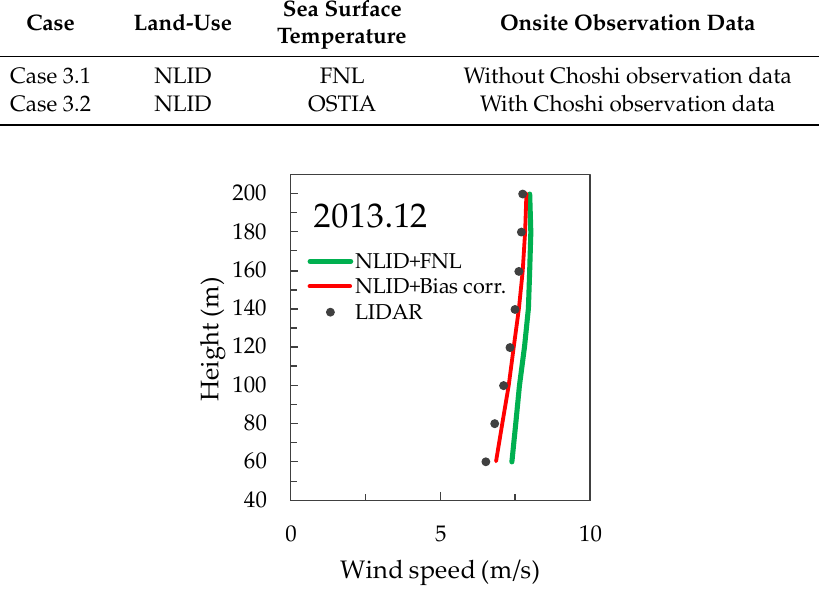
Figure 13. Effect of sea surface temperature on the monthly average wind speed at the Choshi site in December 2013.